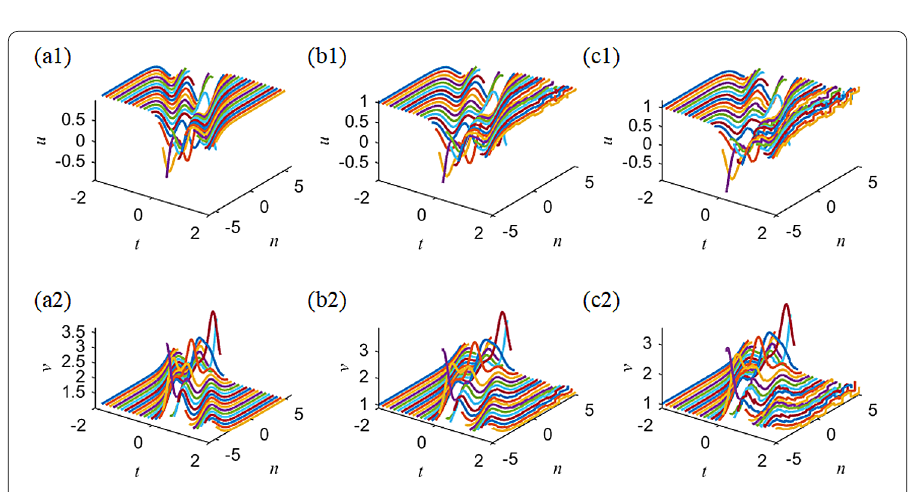
Figure 11 Collisions of three-soliton solutions (cid:8) u n and (cid:8) v n in (50) with N = 2 via the parameters r 1 = 1, r 2 = –1,